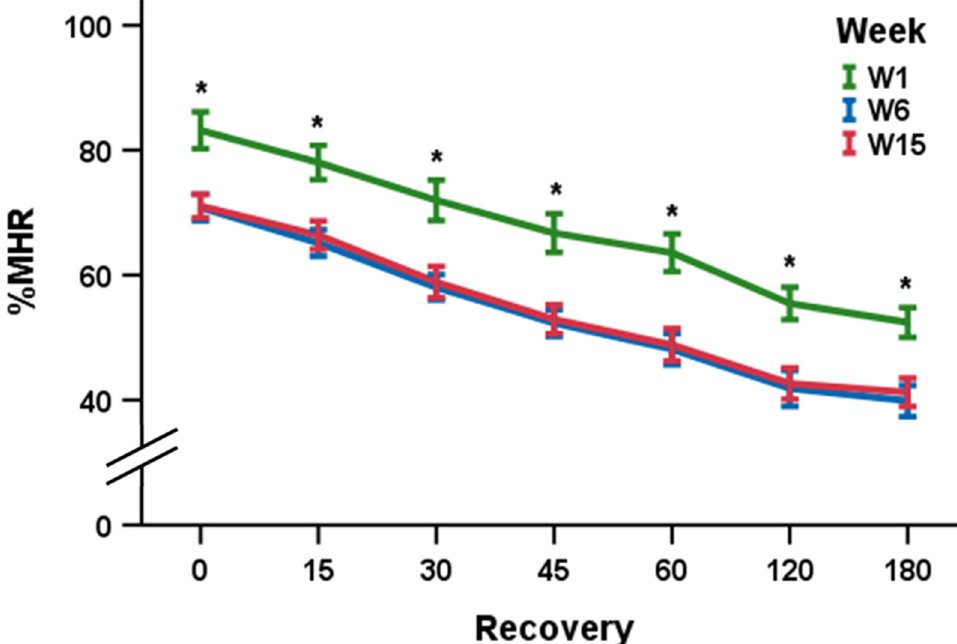
Figure 1. Changes in mean ( ± 95% confidence intervals) percent of age-predicted heart rate maximum (%MHR) during heart rate recovery (HRR) responses among firefighter recruits during firefighter training academy. * %MHR at week 1 (W1) is significantly ( p < 0.001) higher than %MHR at week 6 (W6) and week 15 (W15).